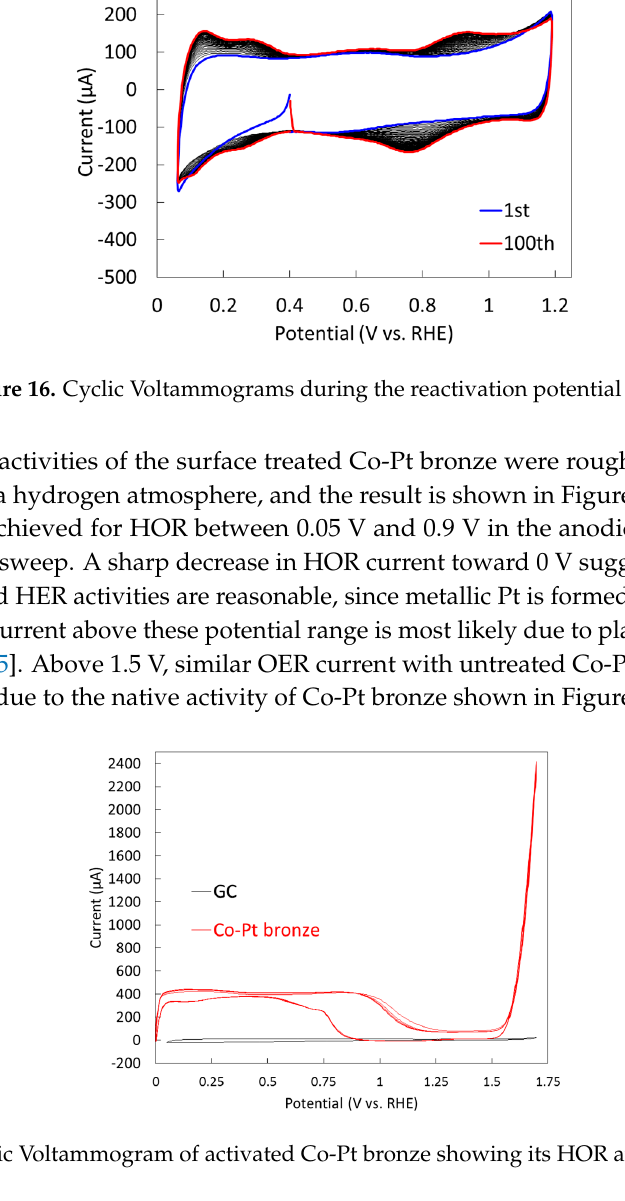
Figure 17. Cyclic Voltammogram of activated Co-Pt bronze showing its HOR and OER activities.